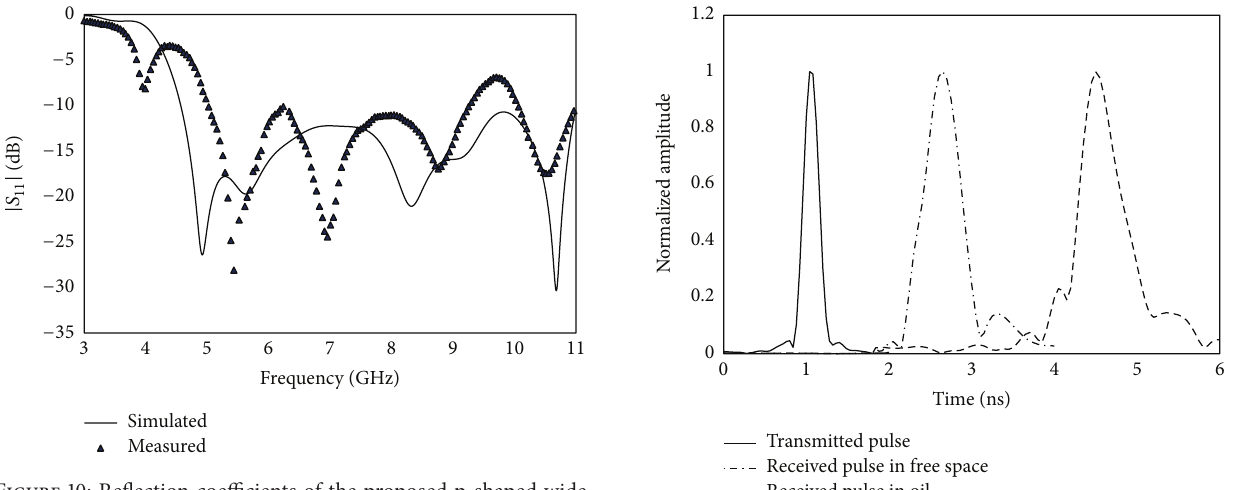
Figure 10: Reflection coefficients of the proposed p-shaped wide- slot antenna, comparing simulated and measured values.